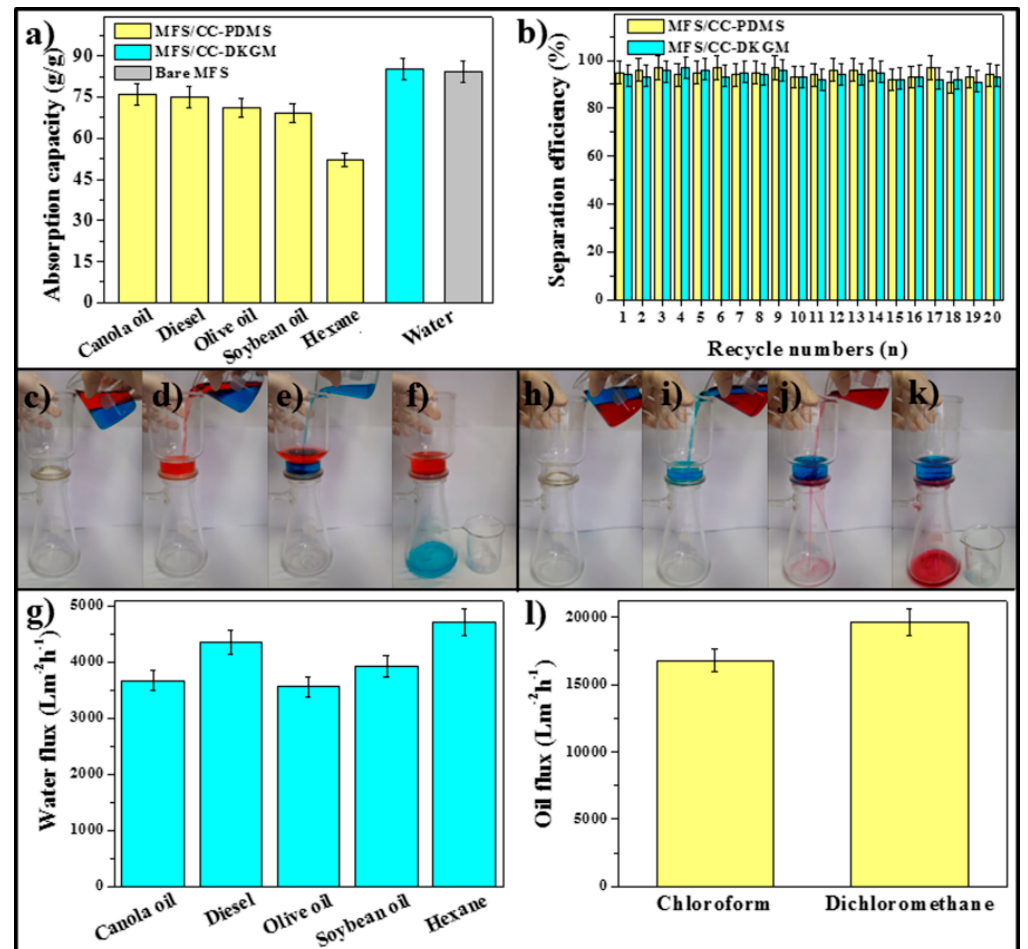
Figure 5. ( a ) Absorption capacities of the MFS/CC-PDMS and MFS/CC-DKGM for various types of oils and water, respectively. ( b ) Reusability tests for hexane and water, with more than 20 consecutive cycles using the MFS/CC-PDMS and MFS/CC-DKGM, respectively. Images showing the oil/water separation process using ( c – f ) MFS/CC-DKGM and (h–k) MFS/CC-PDMS prewetted with ( c – f ) water and ( h – k